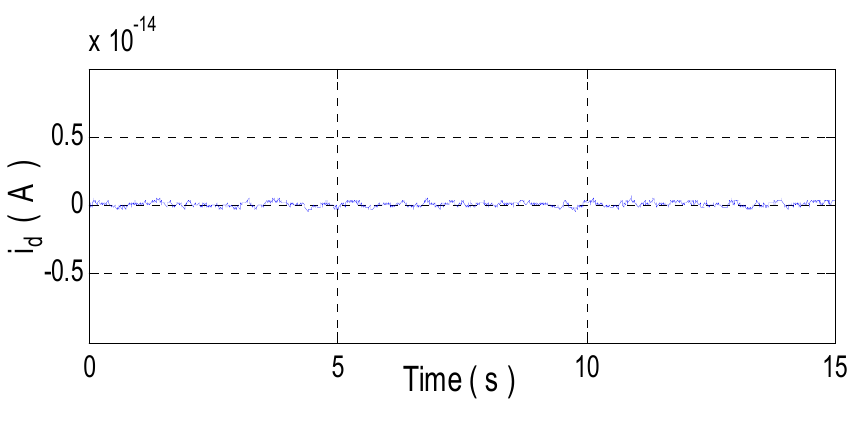
Figure 9. Current i d .